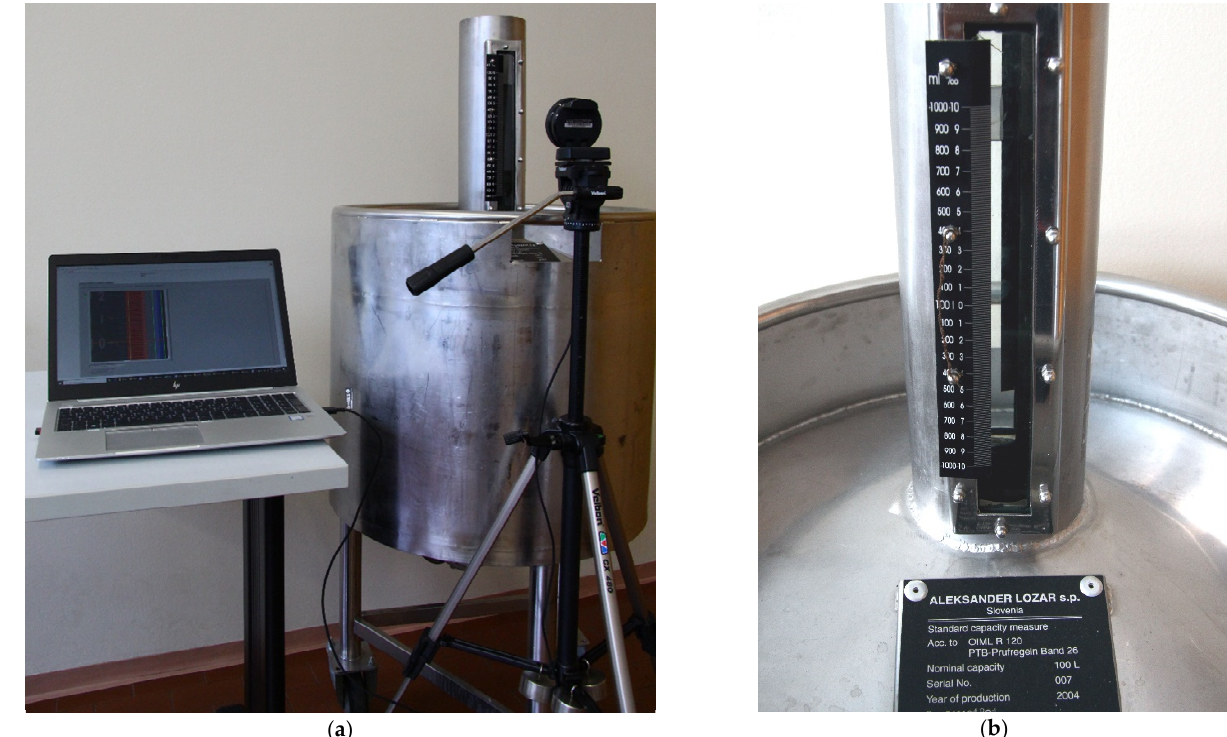
Figure 6. Experimental setup of the measuring system ( a ) and the measuring scale of the capacity measure ( b ). Table 1. Parameters of the experimental setup and their estimated uncertainties ( k = 2).